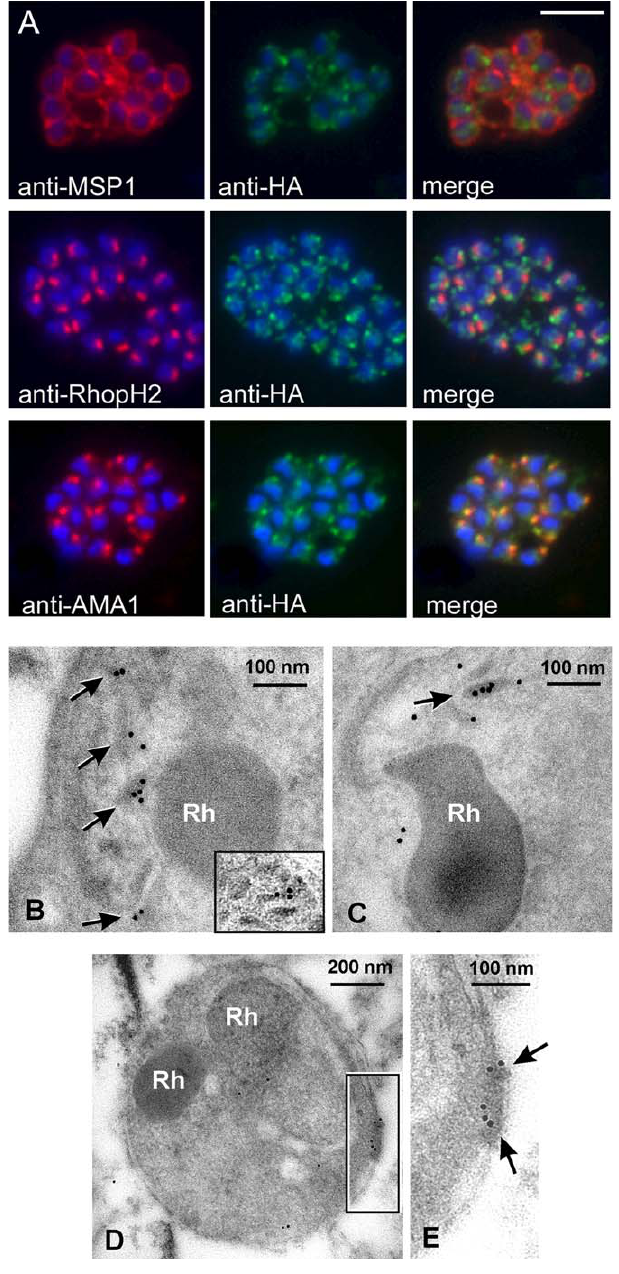
Figure 2. PfSUB2 Is a Microneme Protein (A) IFA images of schizonts of PfSUB2HA clone 2D dual-labelled with mAbs X509 (anti-MSP1), 61.3 (anti-RhopH2), or 4G2 (anti-AMA1), plus in each case mAb 3F10 (anti-HA) The anti-HA signal co-localised only with the anti-AMA1 signal. Identical results were obtained with the uncloned transgenic PfSUB2HA line, and/or when anti-RAP2 mAb H5 was used as the rhoptry marker instead of mAb 61.3 (not shown). Parasite nuclei are stained throughout with DAPI (blue). Scale bar represents 2 l m. (B and C) Electron micrographs showing immuno-gold labelling of micronemes within late-stage schizonts of PfSUB2HA clone 2D using: (B) anti-HA mAb 3F10, detecting epitope-tagged PfSUB2; and (C) a polyclonal antibody specific for PfAMA1. The inset in (B) shows another example of micronemal staining with mAb 3F10 from another schizont. Rh, rhoptry. (D and E) Posterior labelling of with anti-HA mAb 3F10 in a free merozoite of PfSUB2HA clone 2D. Arrows indicate immuno-gold label- ling. Rh, rhoptry. DOI: 10.1371/journal.ppat.0010029.g002